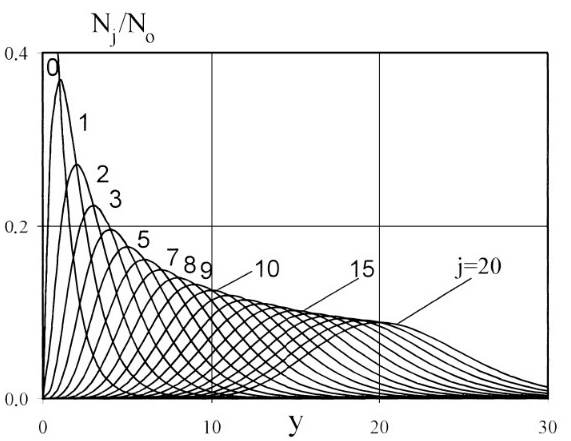
Fig. 1. Relative numbers N j (y)/ N 0 of electrons versus the length of the traversed path y .